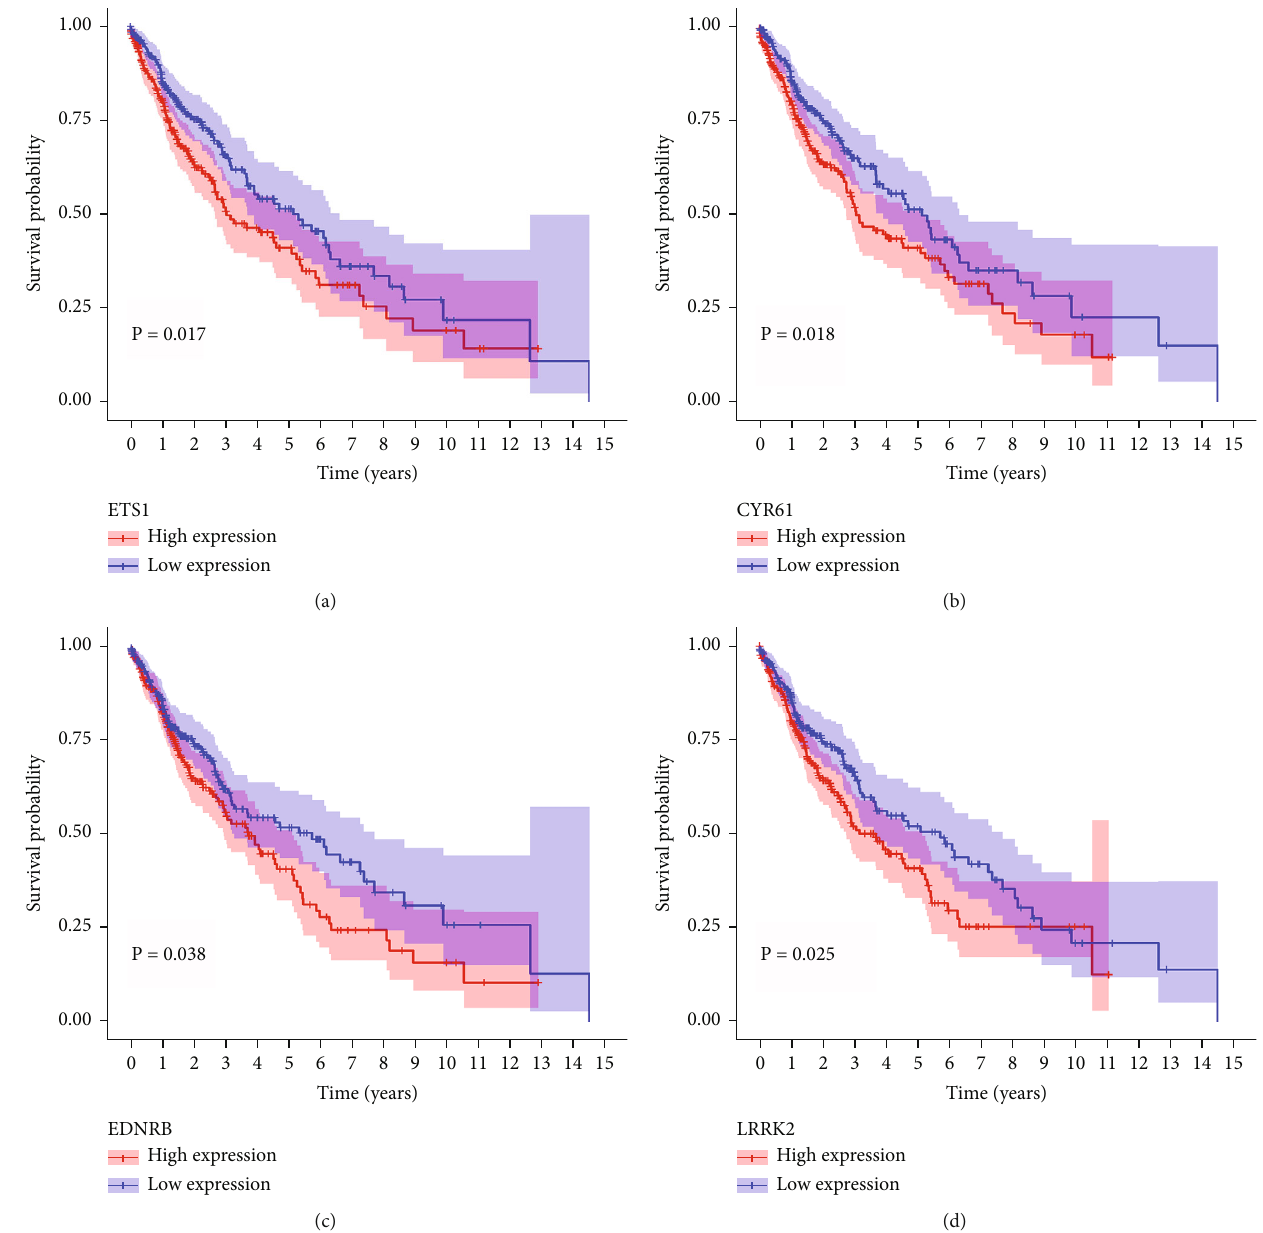
Figure 9: Survival analysis of four prognosis-related hub target genes of miRNA-33a-5p based on TCGA dataset. (a) ETS1. (b) CYR61. (c) EDNRB. (d) LRRK2. P < 0 : 05 indicates a statistically signi fi cant di ff